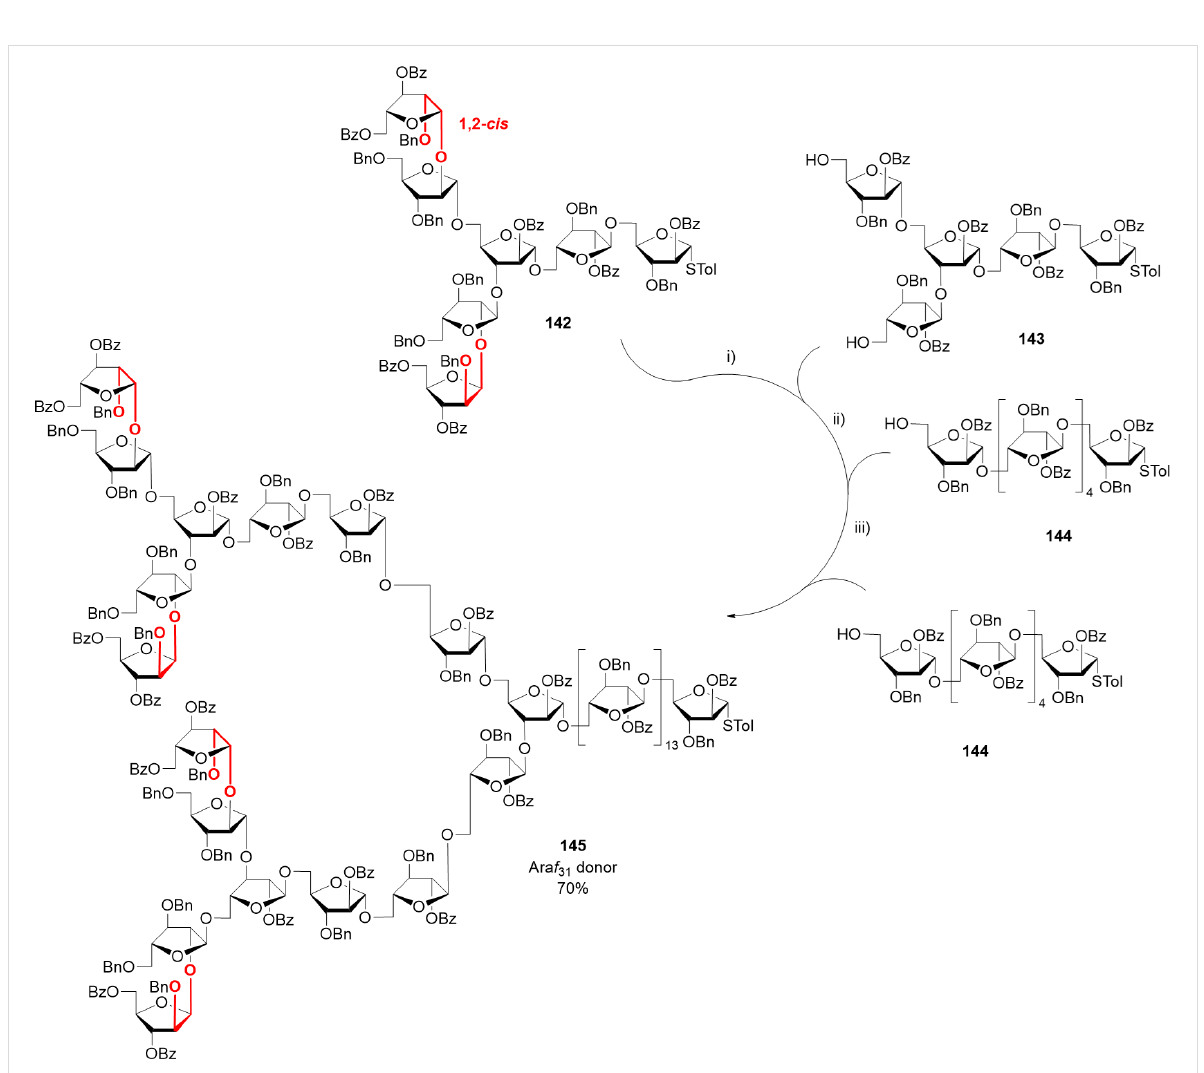
Scheme 19: Synthesis of the branched arabinofuranose fragment using a six component one-pot synthesis. i) TTBP, 4 Å MS, DCM, p TolSCl, AgOTf then 143 , − 78 °C to room temperature. ii) p TolSCl, AgOTf then 144 , − 78 °C to room temperature. iii) p TolSCl, AgOTf then 144 , − 78 °C to room tem-